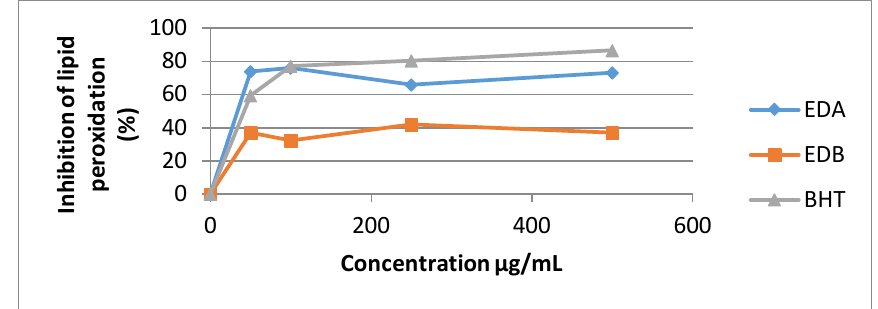
Figure 5. Percentage inhibition of linoleic acid peroxidation of the two E. dendroides extracts.